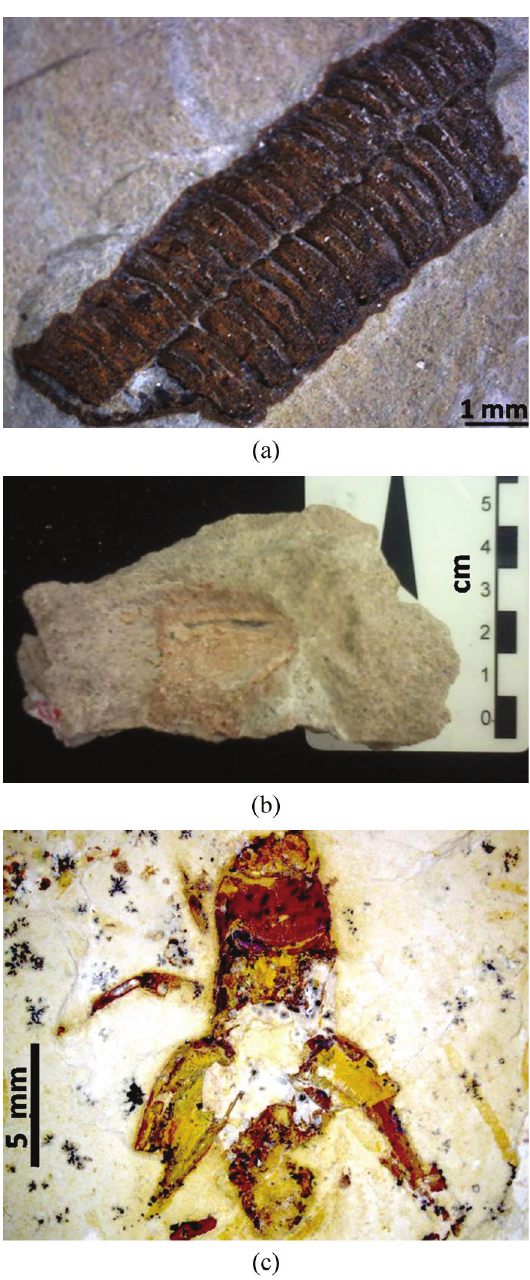
Figure 2. Studied fossils: (a) Corumbella werneri (Ediacaran, Corumbá Group); (b) Unionoida freshwater mollusk (Cretaceous, Bauru Group). (c) Cricket (Cretaceous, Araripe Basin) from IGc/ USP collection, specimen n.